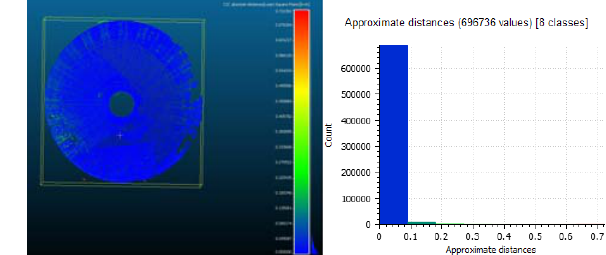
Figure 13: Discrepancy (m) map and histogram between the TLS point cloud and VisualSfM processing.